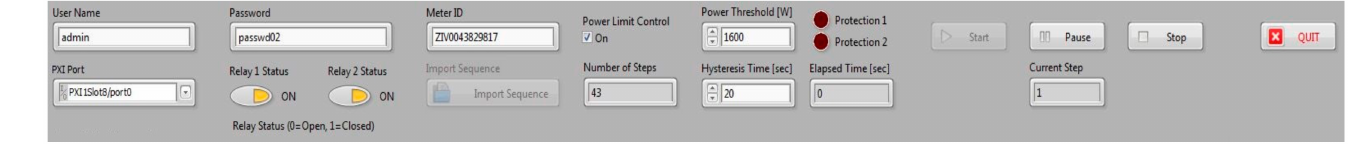
Figure 6. Front panel interface for remote control of the plugs—options for the external actor.